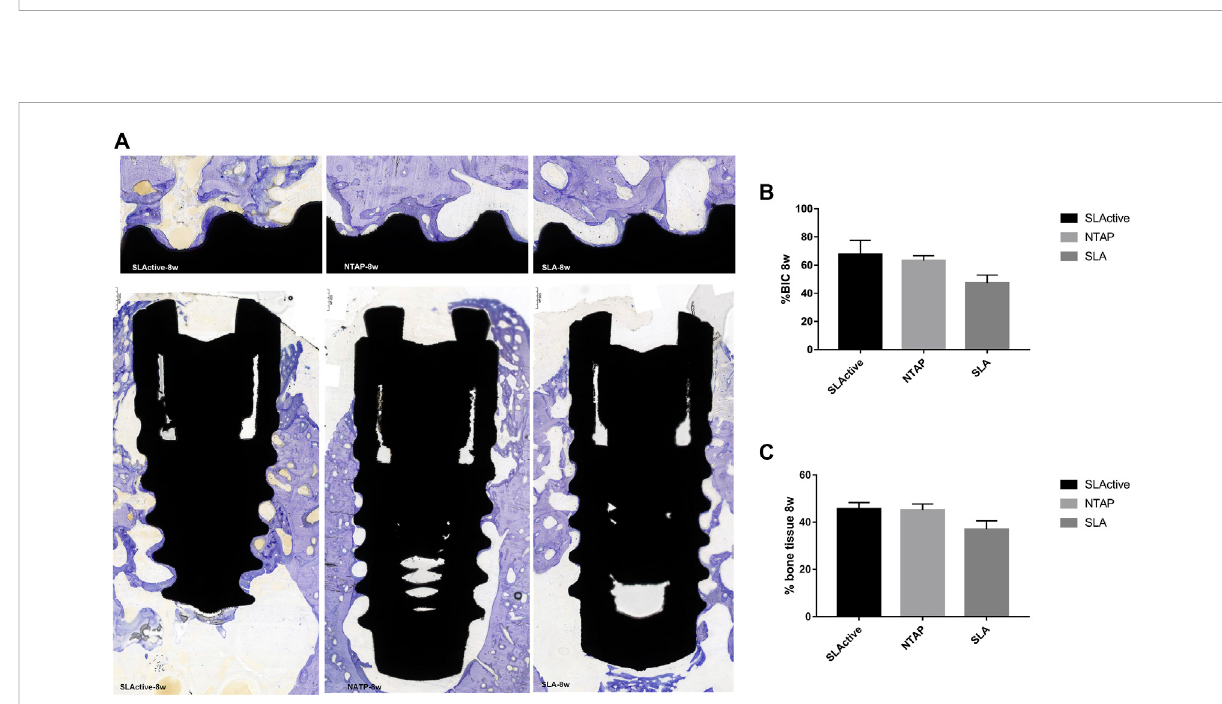
FIGURE 6 Histological section and analysis after 4 weeks of implantation ( n = 3). (A) New bone formation was assessed by toluidine blue staining in the SLActive, NTAP, and SLA groups. Magni fi cation: upper ×10; lower ×2 and scalebar = 500 μ m. (B) Percentage of histological BIC. (C) Percentage of bone tissue in wound chamber. Values represent the means of data obtained from three different experiments with standard deviations. * = p < 0.05 of the Friedman test using IBM SPSS 26 (the error bars indicate standard deviations).